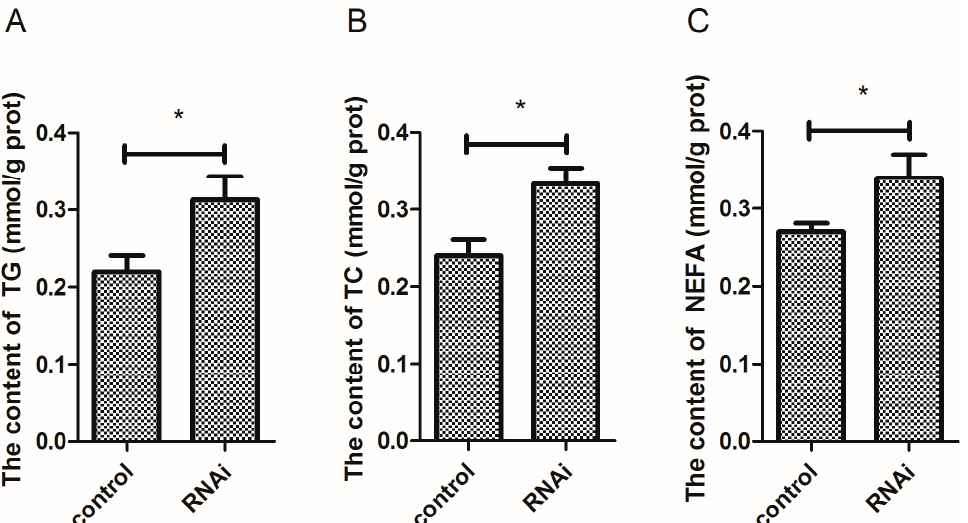
Figure 8. Effect of Wnt10b gene interference on the content of triglyceride (TG), total cholesterol (TC), and non-esterified fatty acids (NEFA) in the muscle. ( A ) TG; ( B ) TC; ( C ) NEFA. Values are expressed as means ± s.e.m. ( n = 4). Statistically significant differences are denoted by an asterisk (* p < 0.05).